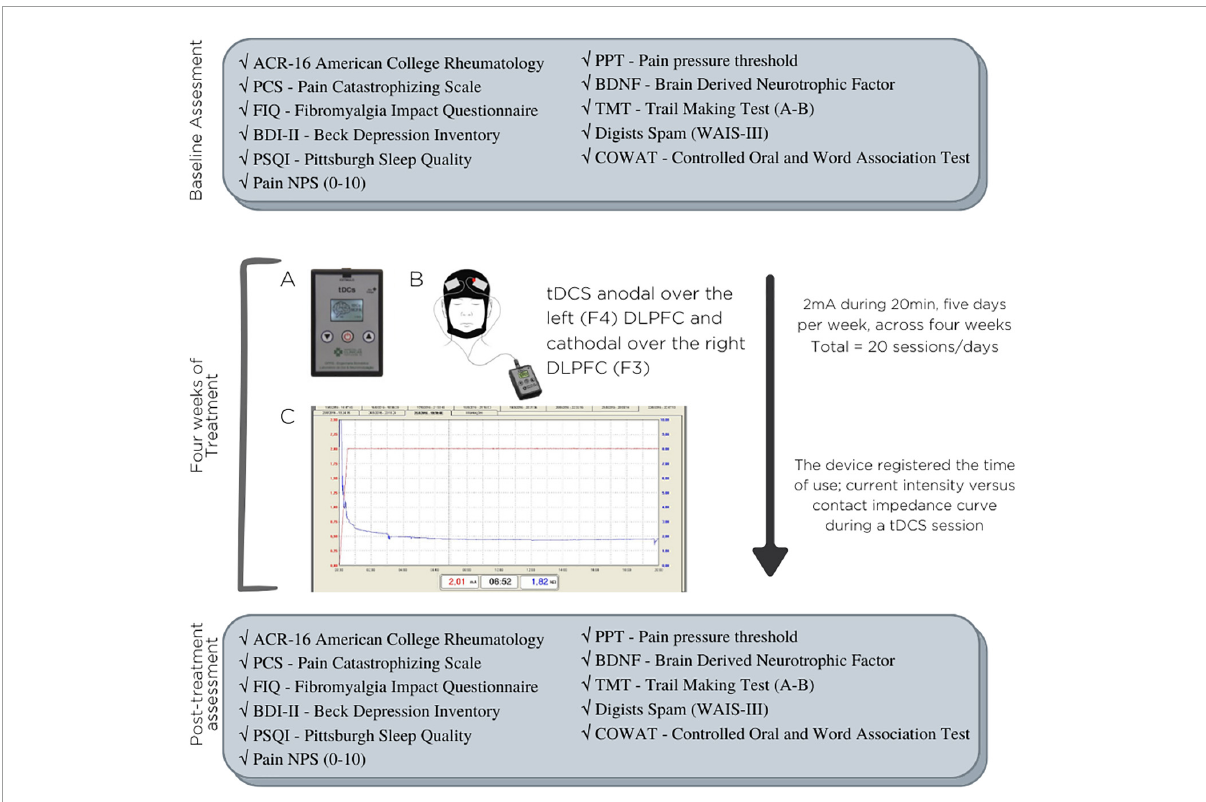
FIGURE1 Timeline of the study. (A) Home tDCS device; (B) position of electrodes on the DLPFC (dorsolateral prefrontal cortex); (C) typical curves of current intensity vs. contact impedance during a tDCS